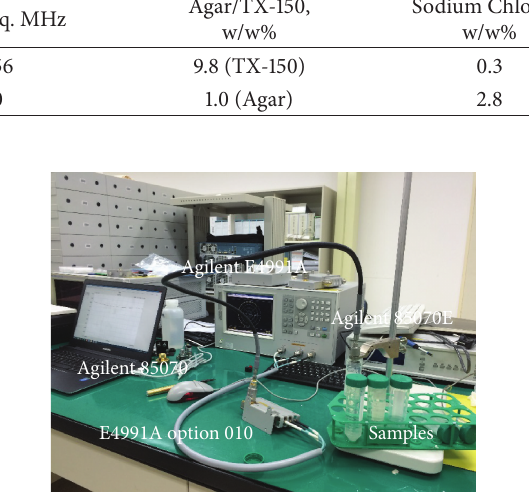
Figure 8: Measurement setup for tissue-emulating materials.